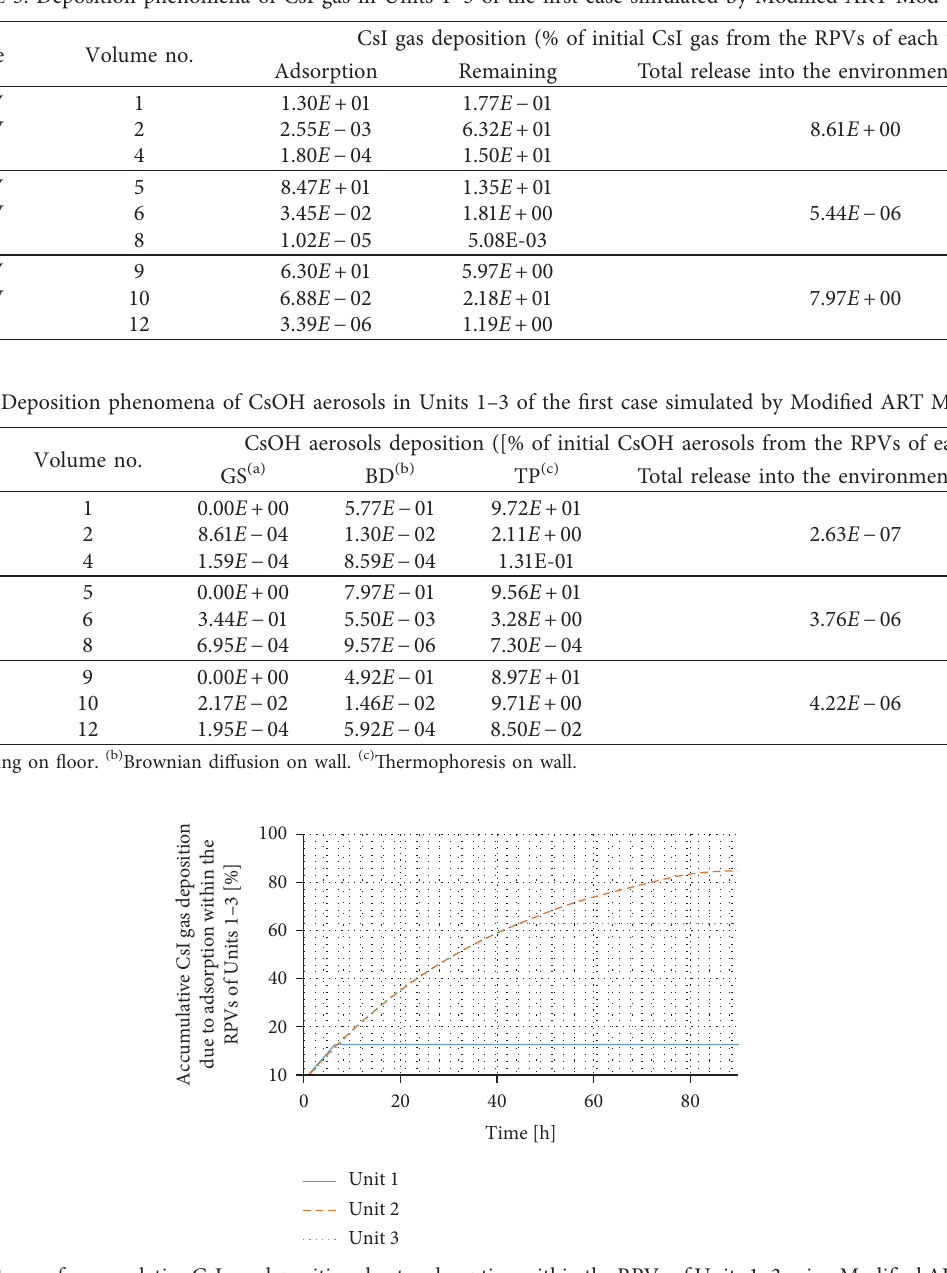
Figure 13: Percentages of accumulative CsI gas deposition due to adsorption within the RPVs of Units 1–3 using Modified ART Mod 2 code of the first